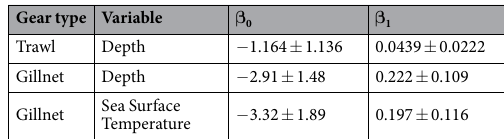
Table 2. Summary logistic regression results for parameters associated with gas embolism in bycaught turtles by gear type. β 0 is intercept and β 1 is the